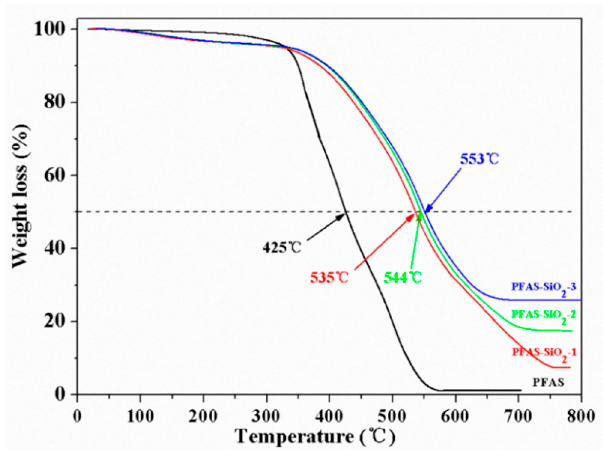
Figure 3. Thermogravimetric diagrams of PFAS and a series of PFAS-SiO 2.